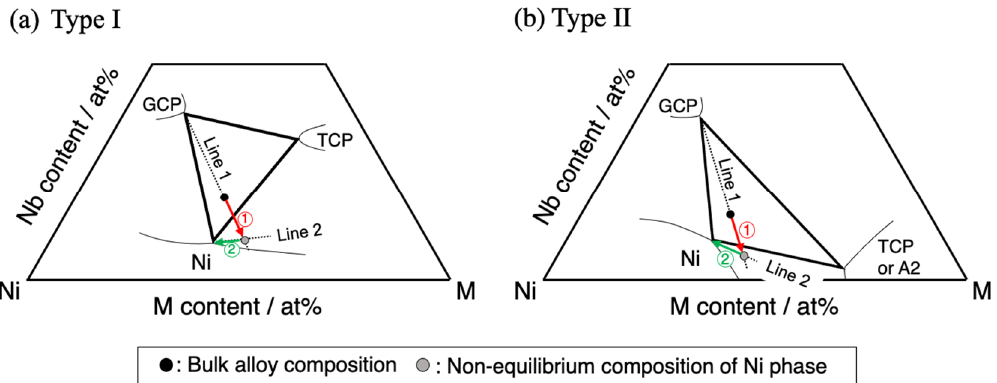
Figure 8. Schematic showing the composition shift in the Ni phase from the bulk composition (black symbol) to a non-equilibrium composition (gray symbol) as a result of precipitation of the GCP phase: ( a ) Type I and ( b ) Type II. Line 1 shows the non-equilibrium tie line that connects the terminal composition of the GCP phase and the bulk composition. Line 2 is the extended phase boundary between the Ni and GCP phases. The intersection of these lines is the non-equilibrium composition of Ni phase at the interface with the GCP phase, which precipitates on the GB prior to the TCP or A2 phase.